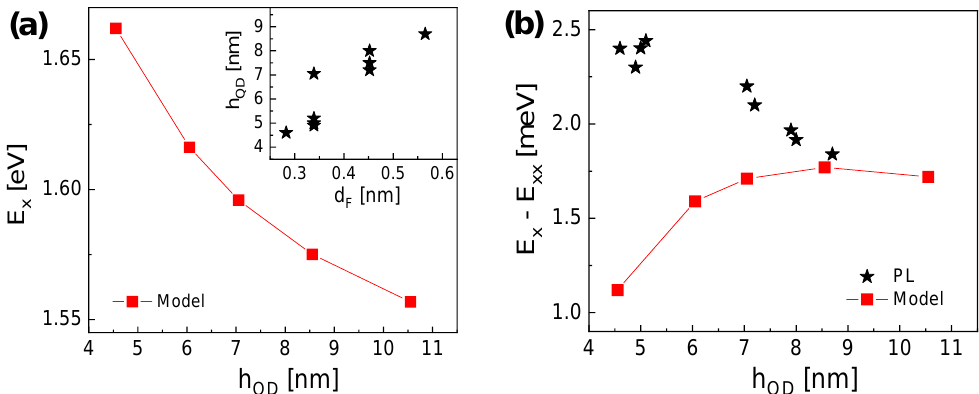
Figure 2. ( a ) Relation between the exciton energy E X and the quantum dot height h QD computed with the atomistic model. The inset shows pairs of h QD and d F , where the values of E X computed with the model agree with the PL measurements. ( b ) Exciton–biexciton splitting measured with PL together with model